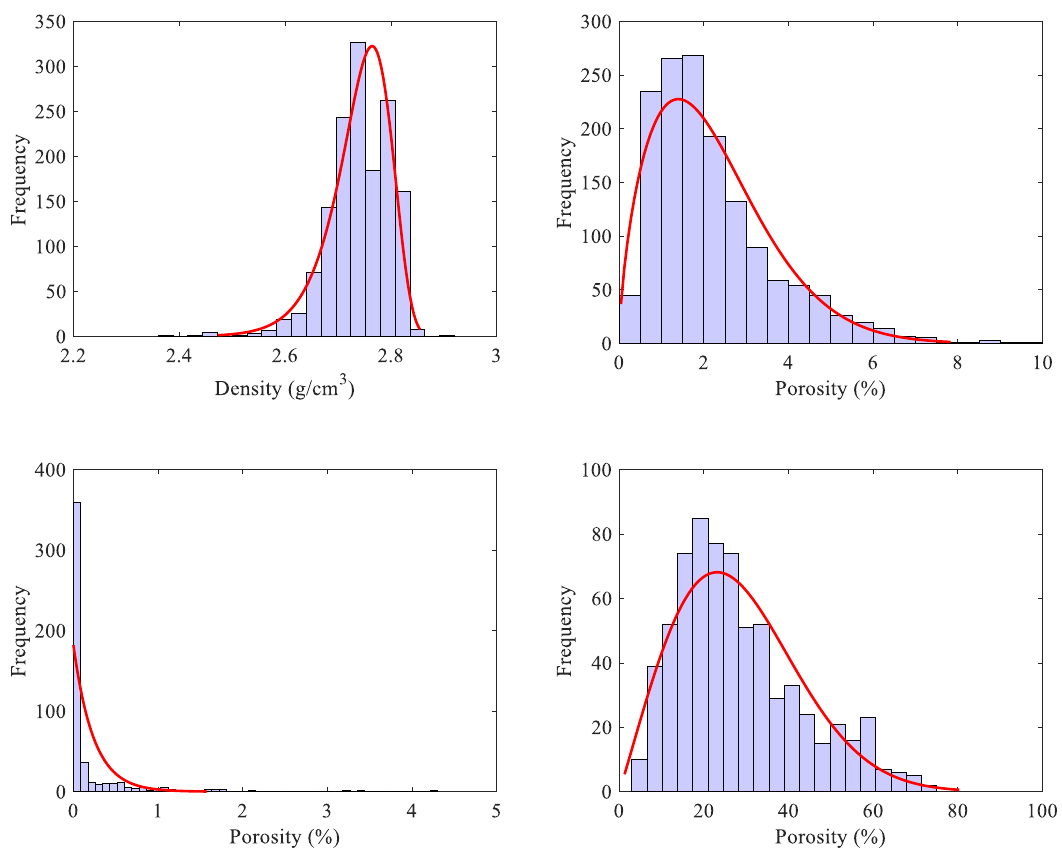
Figure 3. Basic physical properties of full diameter cores. The red line is the fitting curve of the Weibull distribution.